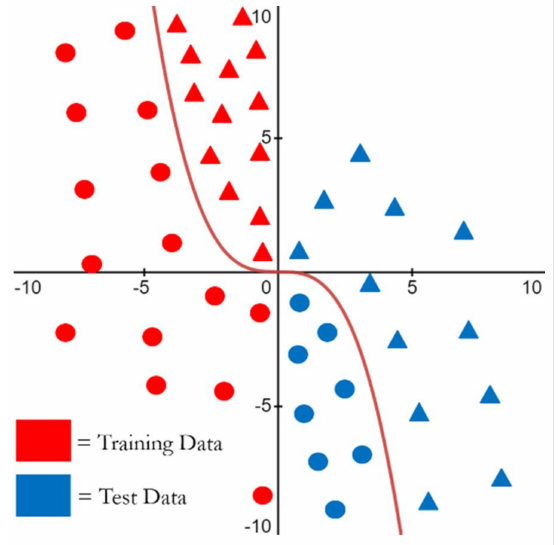
Figure 1. Simple example of covariate shift in classification data. Two classes of data are represented by circles and triangles, with the training dataset marked in red and the test dataset marked in blue. The true decision boundary between the two classes follows the function y = − x 3